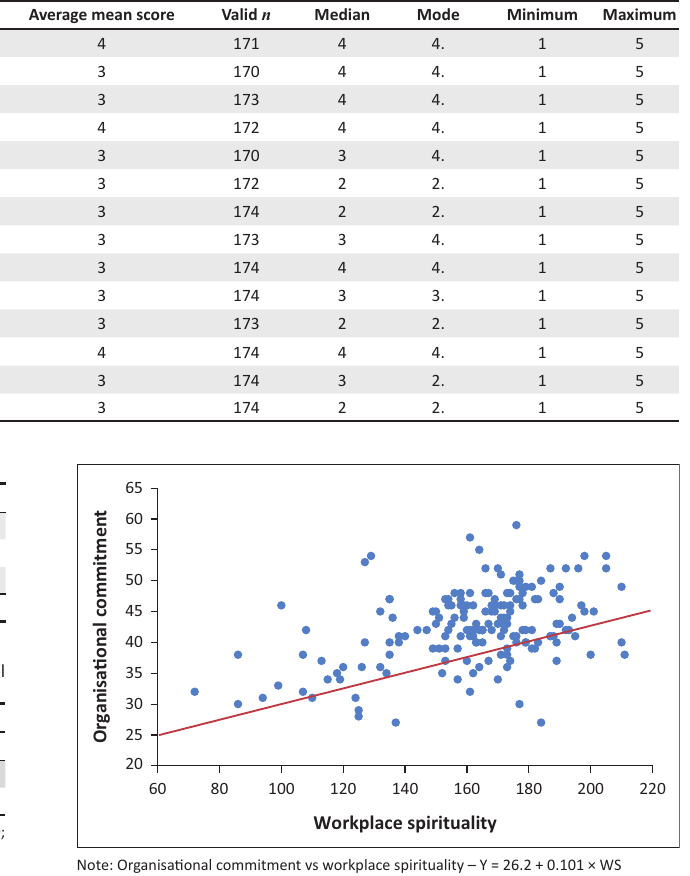
FIGURE 1: Regression line of workplace spirituality versus organisational commitment. Y, organisational commitment; WS, workplace spirituality.